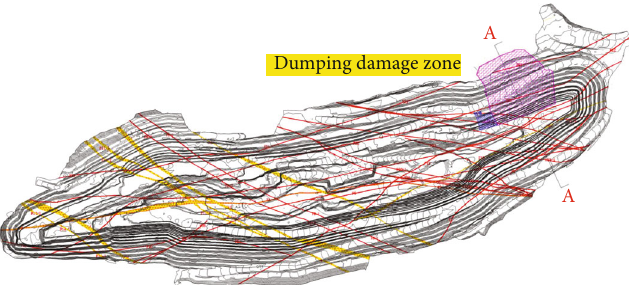
Figure 1: Distribution of fault-cutting and destruction zones in the Southwest